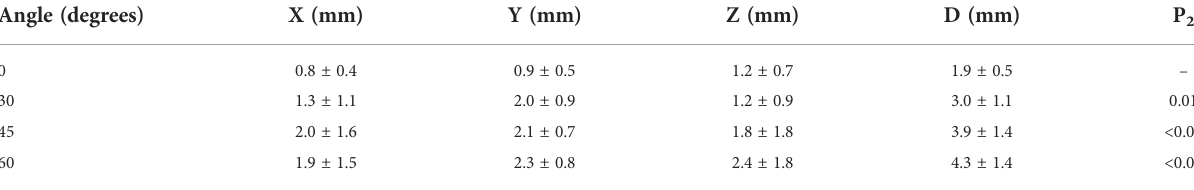
TABLE 2 Errors at different tracking angles.